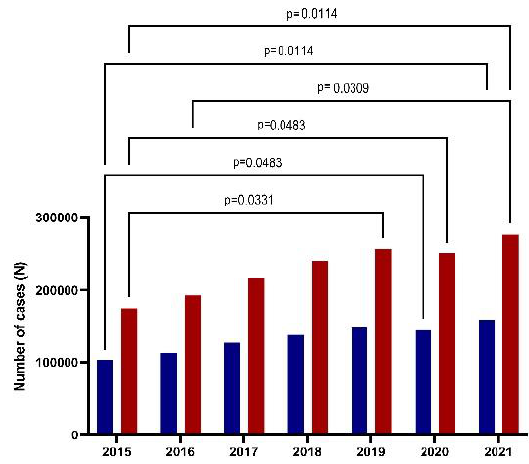
Figure 1. The dynamics of depression cases among years of study (2015 – 2021) for males (blue) and females (red). (Marascuilo procedure with semnificative critical values).